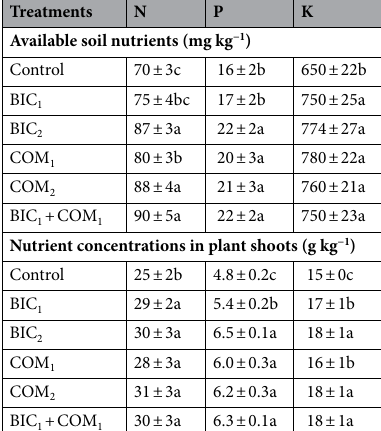
Treatments N P K Available soil nutrients (mg kg −1